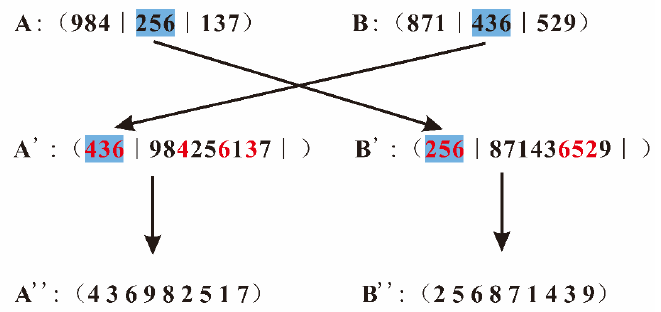
Figure 5. Example of the crossing operation.